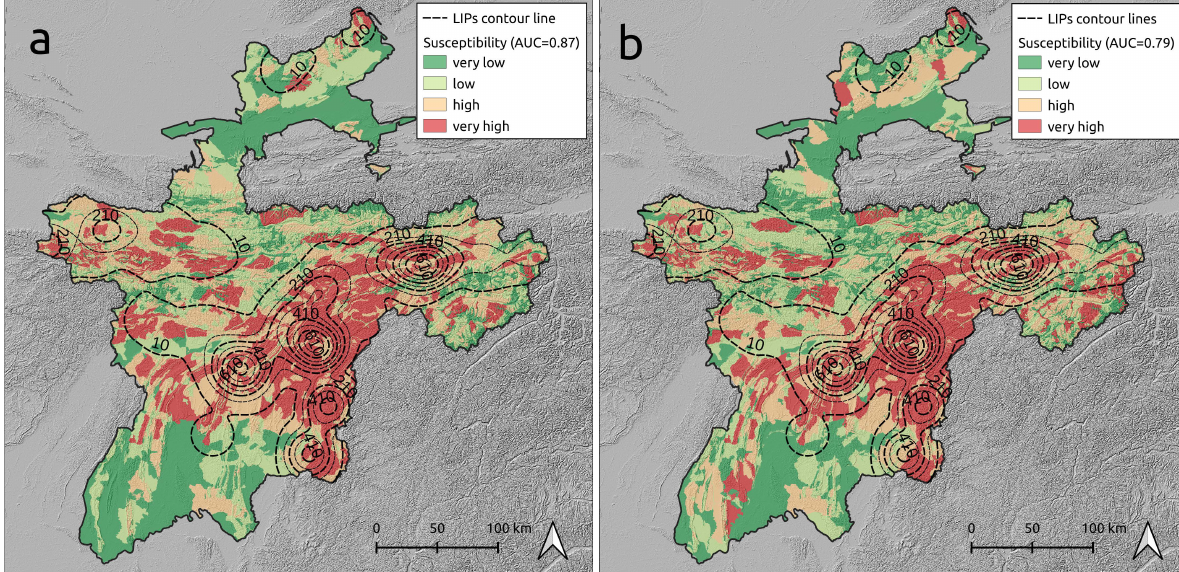
Figure 9. ( a ) 10-runs median susceptibility map with 100% of total landslide inventory (AUC = 0.87) classified in quartiles and the contour lines of the landslides density distribution; ( b ) 10-runs median susceptibility map with 5% of total landslide inventory (AUC = 0.79) classified in quartiles and the contour lines of the landslides density